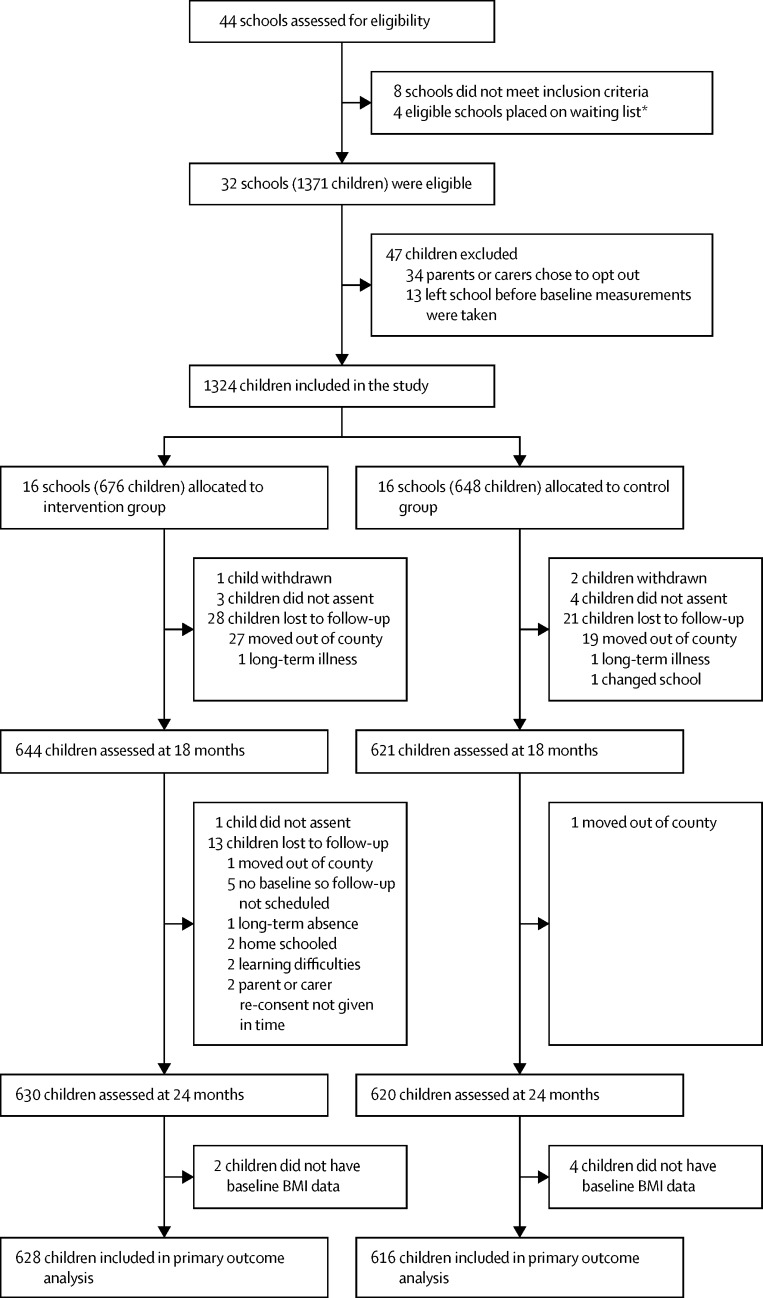
Trial profile*Two schools that had been allocated to cohort 2 withdrew while waiting to commence the trial and so were replaced with two of the four schools on the waiting list before cohort 2 commenced the trial. All schools that started the trial remained in the trial and so all the randomised clusters are present at baseline and at each follow-up point. BMI=body-mass index.